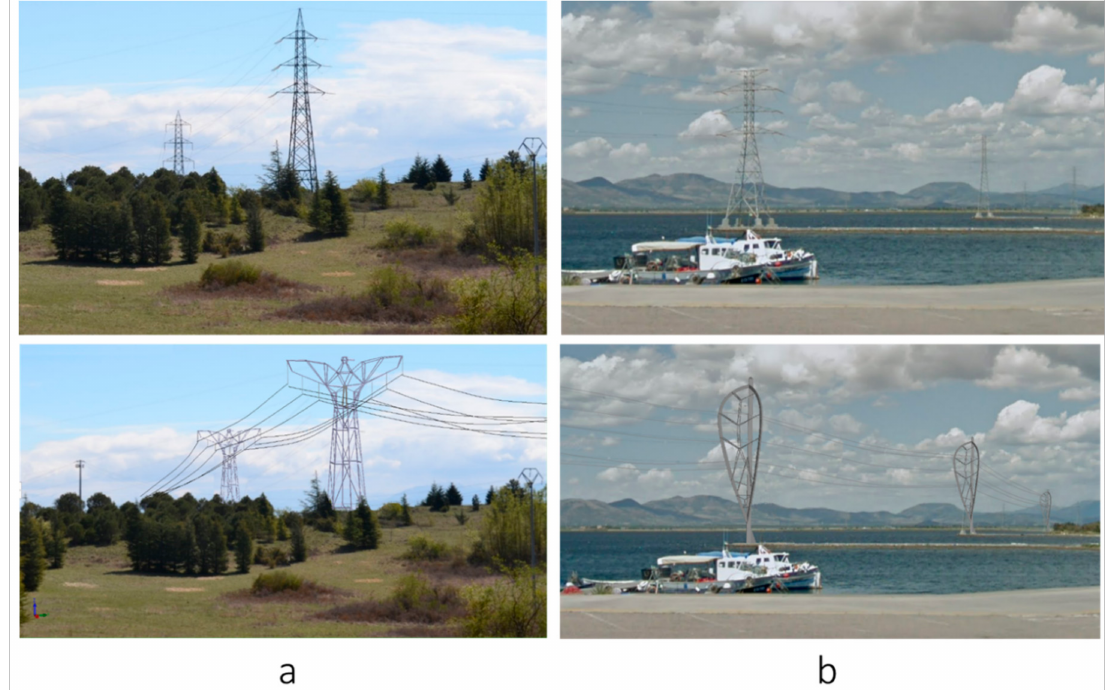
Figure 17. Traditional pylons (top) vs. renders of the developed eagle-shaped and sail-shaped pylons (bottom) in the internal ( a ) and coastal ( b )